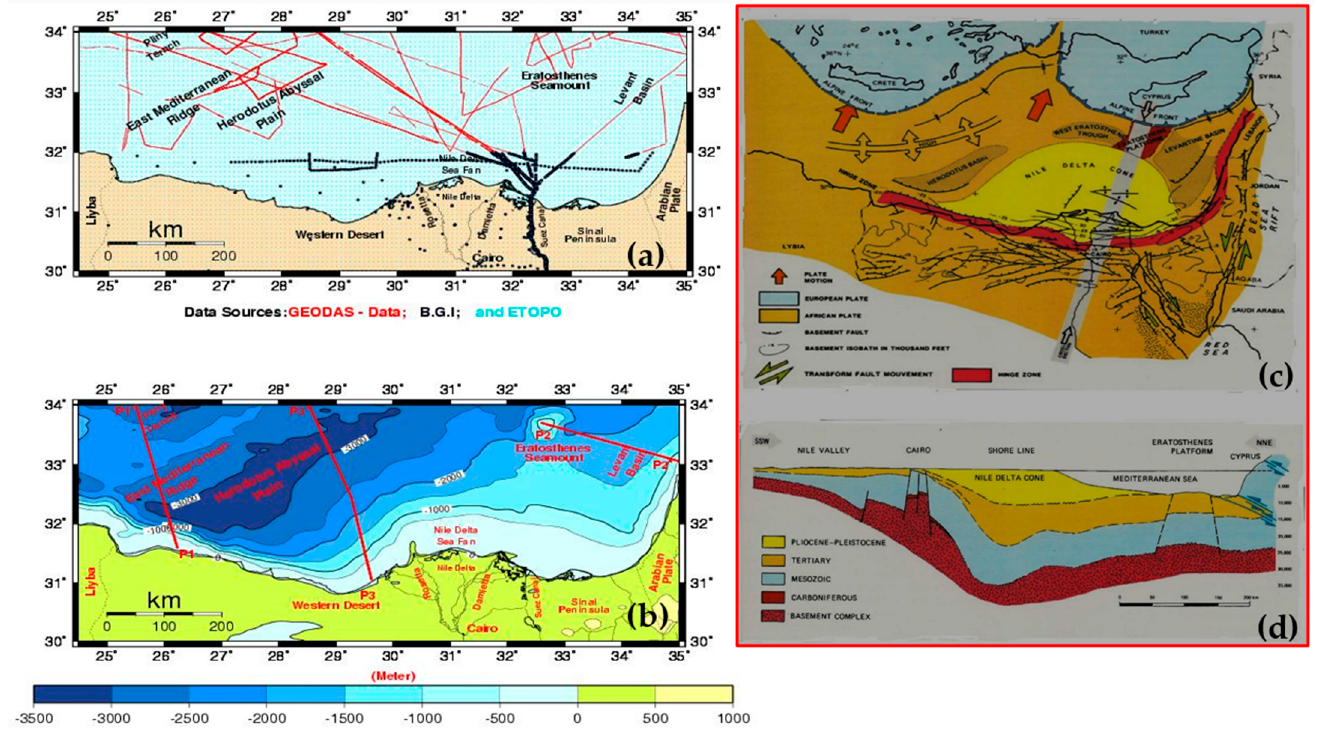
Figure 1. ( a ) Location map of the area under investigation. The heavy line mark indicates the site of collection for the data sources obtained from [15–17]. ( b ) Bathymetric and topographic feature map of the area investigated. The thick red line represents the site of the three seismic profiles (P1–P1 ″ , P2–P2 ″ and P3–P3 ″ ). ( c , d ) Sketch showing regional tectonic setting in the study area and its environs; and the lower diagram shows a schematic cross-section along the line indicated in the upper part respectively modified from [18].